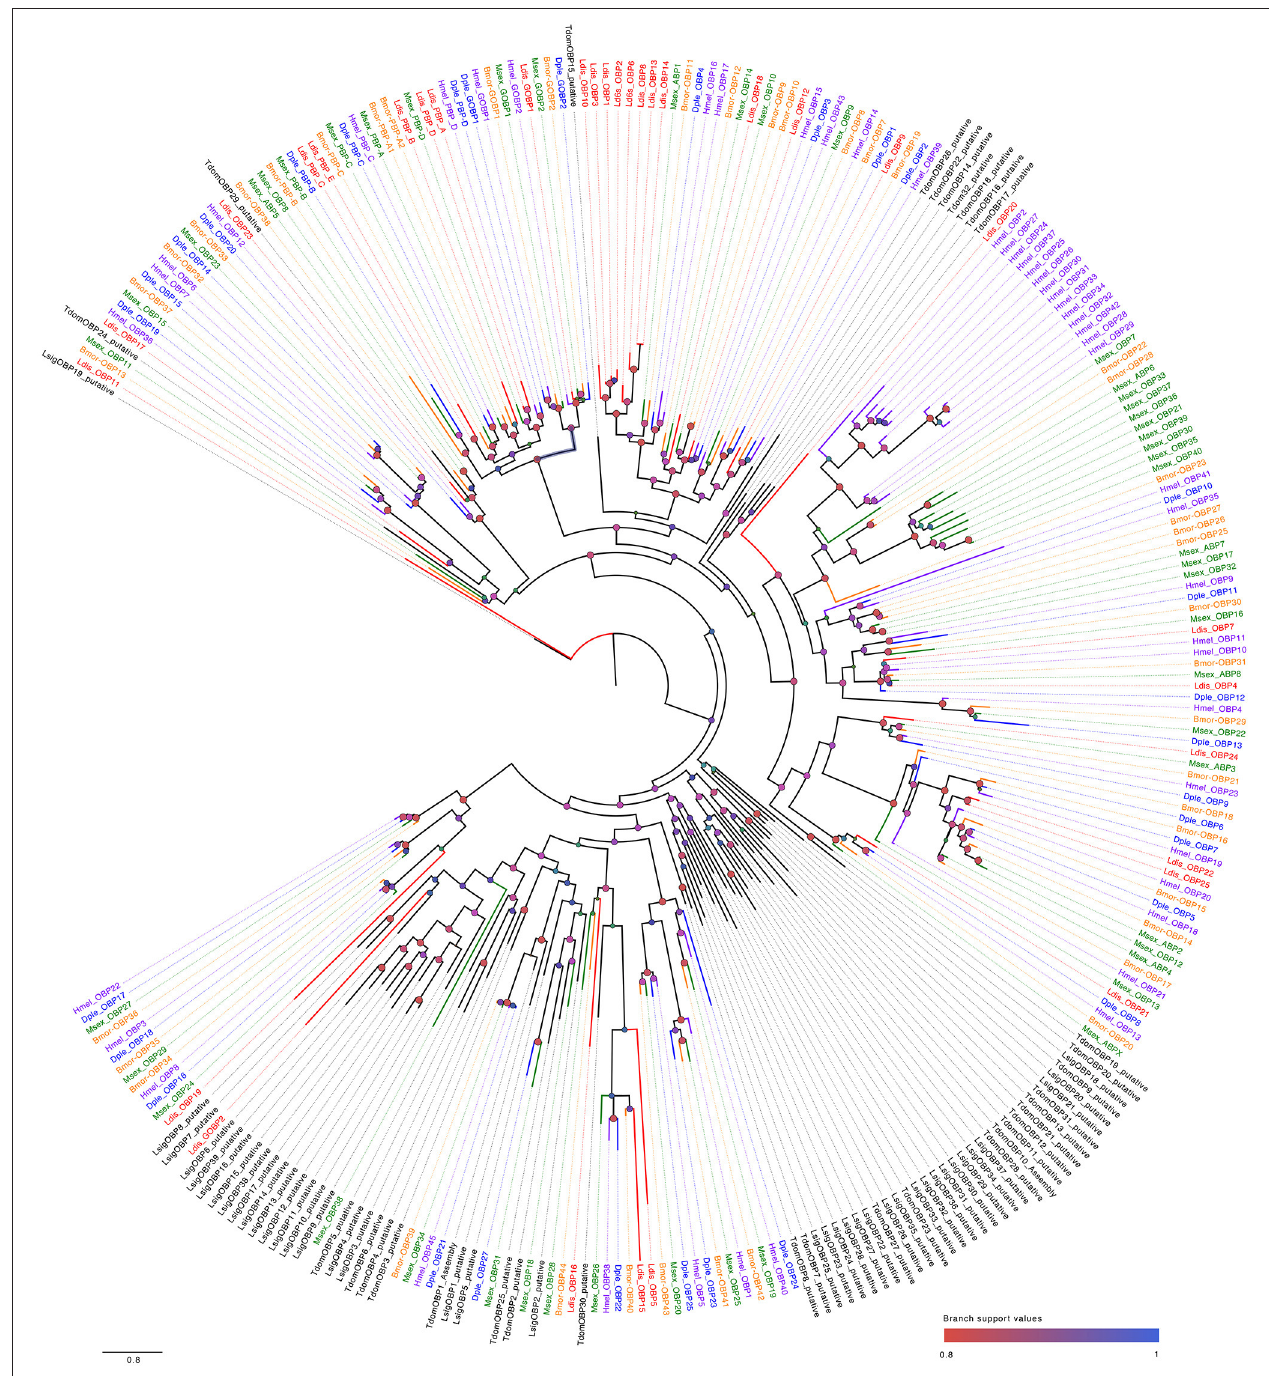
FIGURE 4 | Maximum likelihood dendrogram based on protein sequences of candidate odorant binding proteins (OBPs). Included are the putative sequences for Lymantria dispar (Ldis) plus those available for model Lepidoptera species Bombyx mori (Bmor), Danaus plexippus (Dple), Heliconius melpomene (Hmel), and Manduca sexta (Msex), we also included sequences from the Jumping Bristletail Lepismachilis y-signata (Lsig) and the Firebrat Thermobia domestica (Tdom).